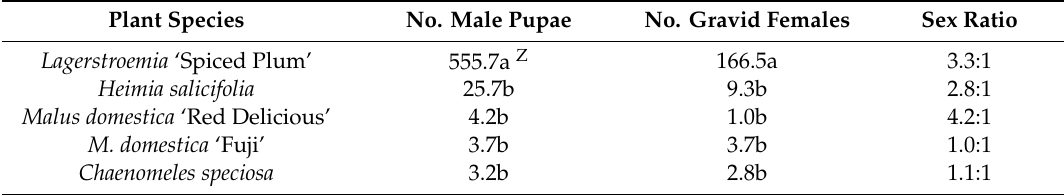
Table 3. The number of male pupae and gravid females, and sex ratio (male to female ratio) on five plant species and cultivars infested with Acanthococcus lagerstromiae in September 2019. Plant Species